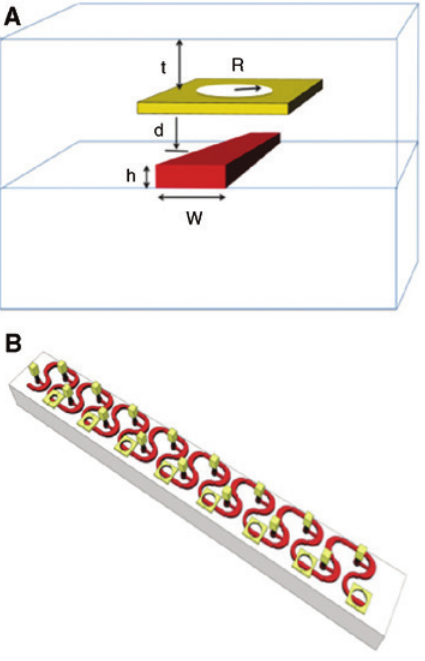
Figure 15: (A) Schematic of the circular aperture antenna (yellow) evanescently coupled to the waveguide (red). (B) A 1 × 8 linear antenna array schematic with integrated thermo-optic phase shift- ers. Reprinted by permission of The Optical Society [60].